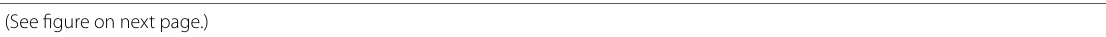
resistance(See figure on next Fig. 7 miR1432 and its target genes regulate rice yield traits. a The gross morphology of the OX1432, MIM1432, OXEFH1, and OXACOT lines planted in a paddy yard during the normal growing season in Sichuan province, the Southwest of China in 2020. Scale bars, 50 cm. b – e the panicle number, grain number per panicle, grain weight, and grain yield per plant of the indicated lines. Data are shown as mean Different letters above the bars show significant differences ( P < 0.05) as determined by the One‑way Tukey–Kramer test. f Photo of grains per plant of the OX1432, MIM1432, OXEFH1, OXACOT lines, and the Nipponbare control. Bars grain yield via OsEFH1 and OsACOT1 that play different roles in the regulation of yield and